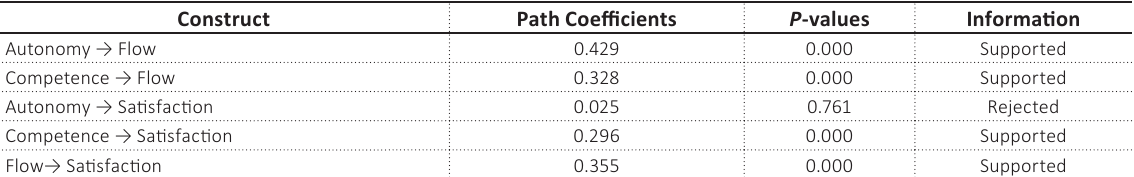
Table 6. Path coefficient and p-value of extreme adventure tourism